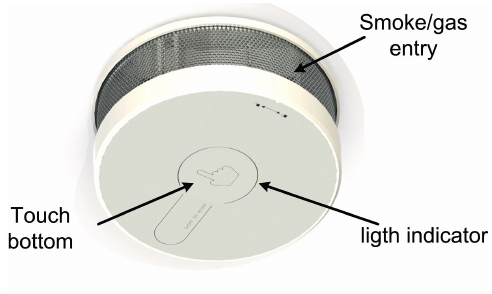
Figure 9. Package design.